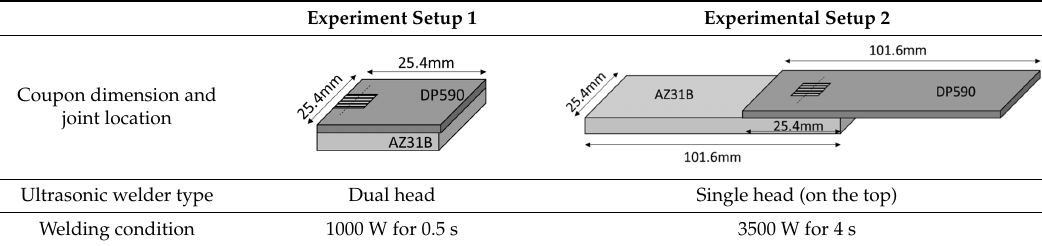
Table 1 . Ultrasonic spot welding (USW) joint coupons produced with different welding conditions.